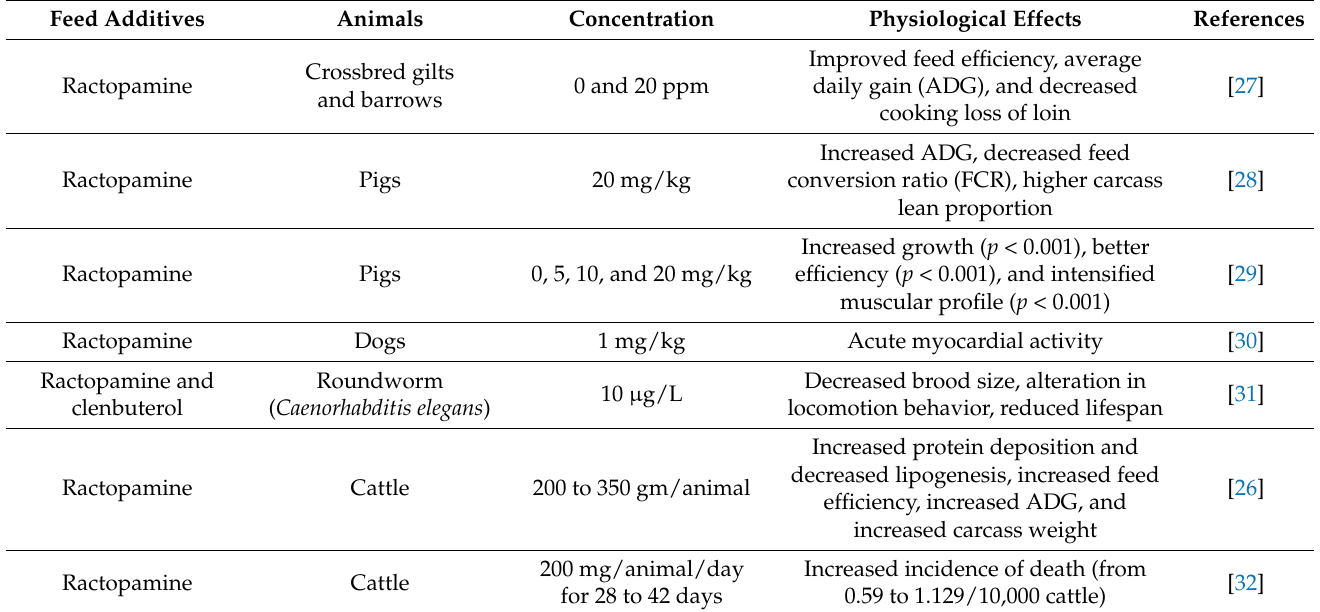
Table 1. Summary of the physiological effects of ractopamine administration in livestock